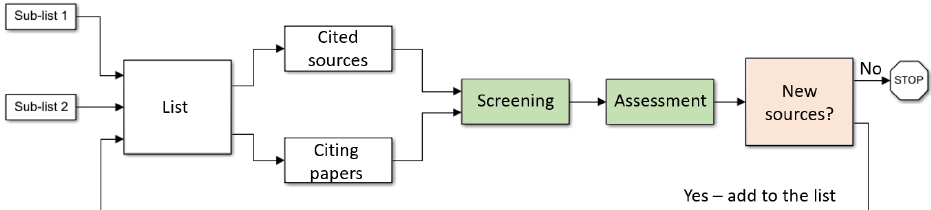
Figure 1. Block diagram of the performed search. Sub-list 1: all COVID-19 papers published in 2020 in the highest-impact journals in the fields of medicine and economics. Sub-list 2: pre-2020 publica- tions of selected authors directly related to the COVID-19 crisis management. Screening: initial screening performed by the first author (MY). Assessment: final assessment performed by both au- thors. New sources: cited sources and citing papers leftover after the two-stage screening.